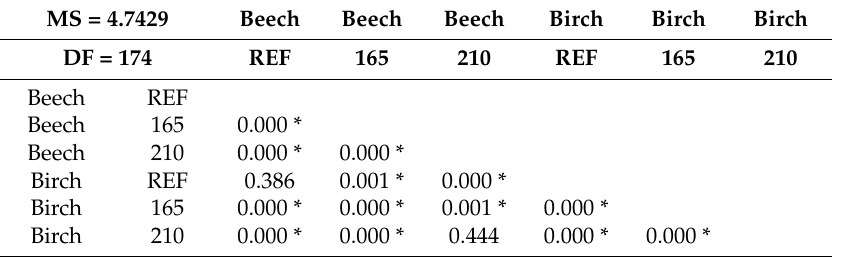
Table A6. Duncan’s Multiple Range Test for Toughness.